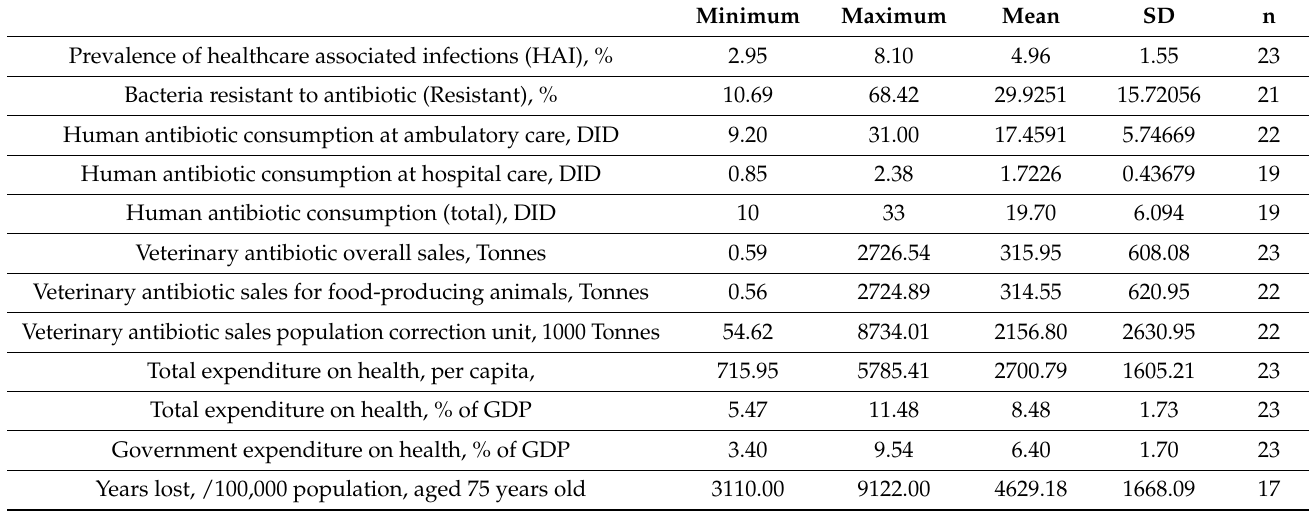
Table 1. Descriptive statistics of the variables included in the study.